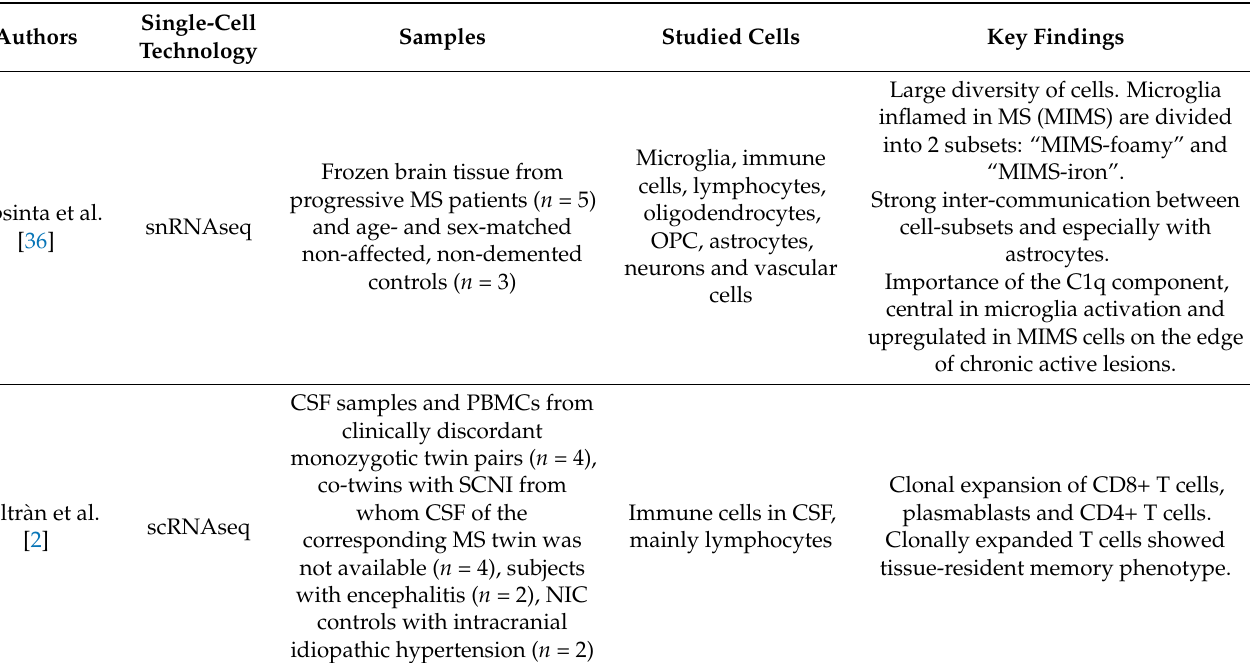
Table 1. Overview of the studies that used single-cell technologies described in this review.